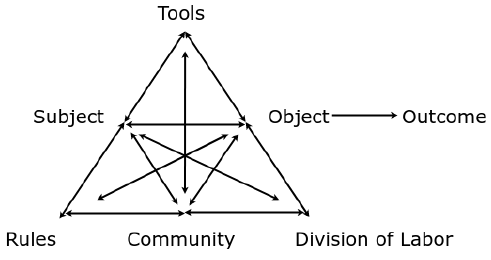
Figure 1. Activity System [33].